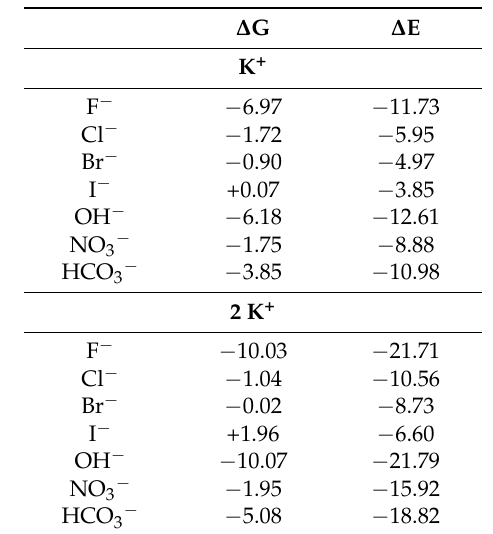
Table 6. Energetics (kcal/mol) for interactions between anions and one or two K + cations.